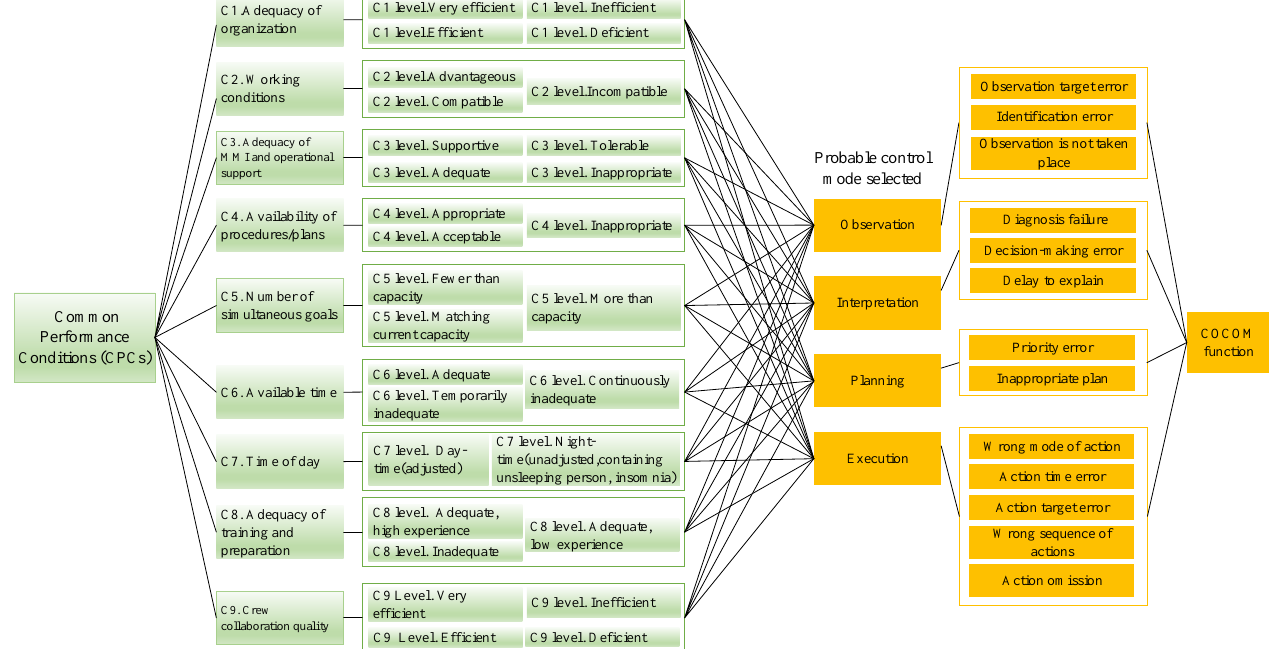
Figure 2. The relationships of CPCs and COCOM functions.